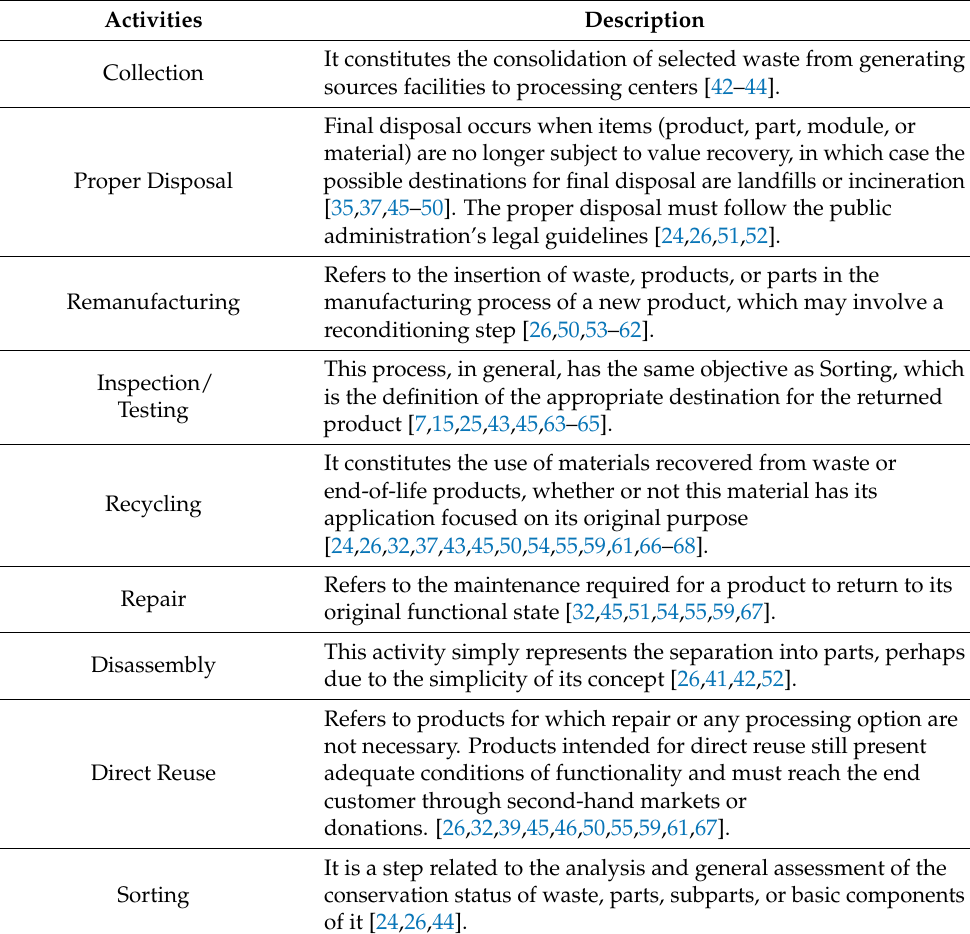
Table 3. Summary of most-cited RL activities definitions in the